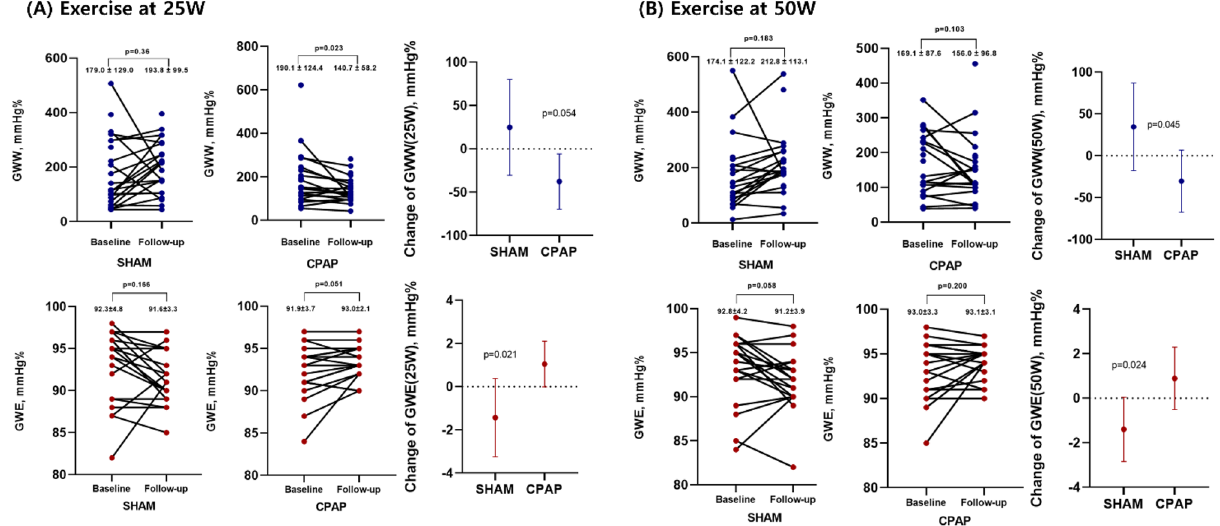
Figure 3. Changes in GWW and GWE in the two study groups according to exercise. ( A ) Changes at 25 W and ( B ) at 50 W. CPAP, continuous positive airway pressure; GWE, global work efficiency; and GWW, global wasted